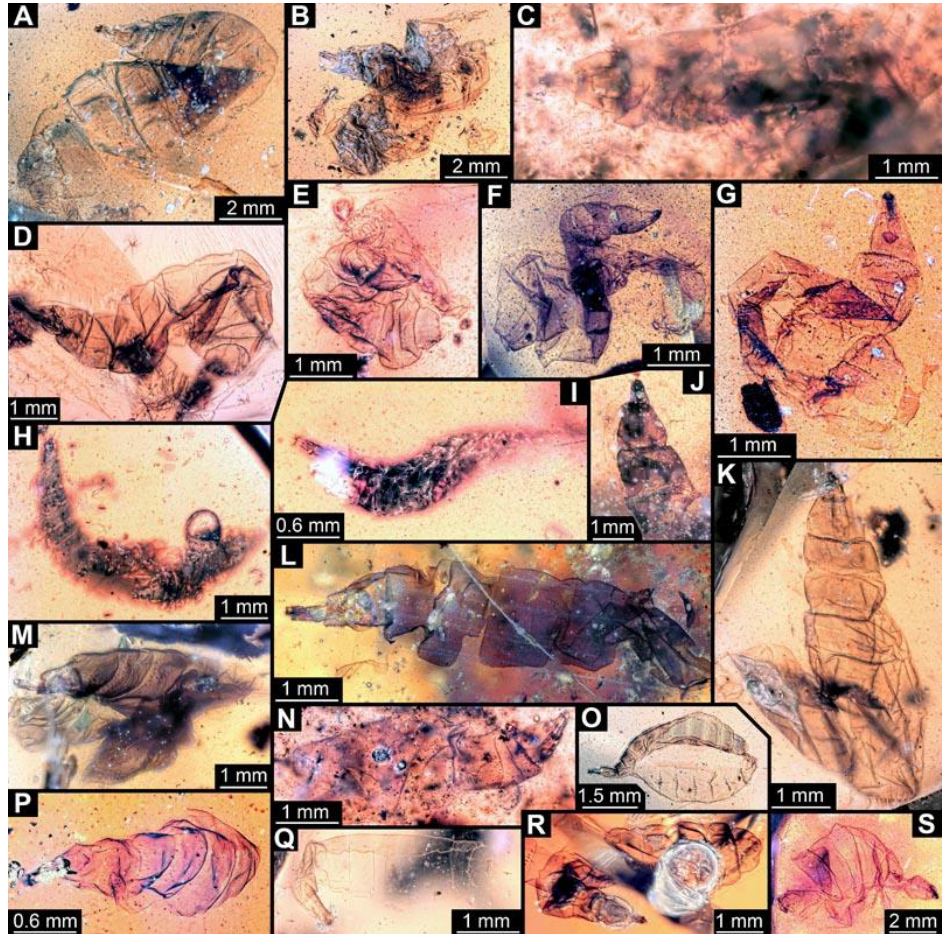
Figure 9. Several fossil larvae. ( A ). PED 0622. ( B ). PED 0653. ( C ). PED 0761-1. ( D ). PED 0729. ( E ). PED 0743. ( F ). PED 0749. ( G ). PED 0752. ( H ). PED 0744-1 and PED 0744-2. ( I ). PED 0744-3. ( J ). PED 0771. ( K ). PED 0770. ( L ). PED 0761-2. ( M ). PED 0762. ( N ). PED 0761-3. ( O ). PED 0846. ( P ). PED 0766. ( Q ). PED 0811-3. ( R ). PED 0817. ( S ). PED 0923. (48) PED 1137: Specimen only accessible in dorsal view, concealed by numerous bub- bles (Figure 10F). Surface structure apparent. Head capsule missing, but width could be (31) PED 0749: Specimen very crumpled (Figure 9F). Surface structure approximated by opening of prothorax. Short spine-like setae on thorax segments well developed. Dimensions: body width 1.18 mm, head capsule width 0.21 mm. (49) PED 1560: Specimen torn apart in ventral and dorsal halves from thorax to trunk end (Figure 10G). Numerous dirt particles and air inclusions conceal details. Surface struc- ture apparent. Head capsule well preserved. Short spine-like setae on thorax segments and longer ventral spine-like setae on abdomen segments well developed. Total body length could not be measured. Dimensions: body width 1.33 mm, head capsule length 0.83 mm, head capsule width 0.12 mm.